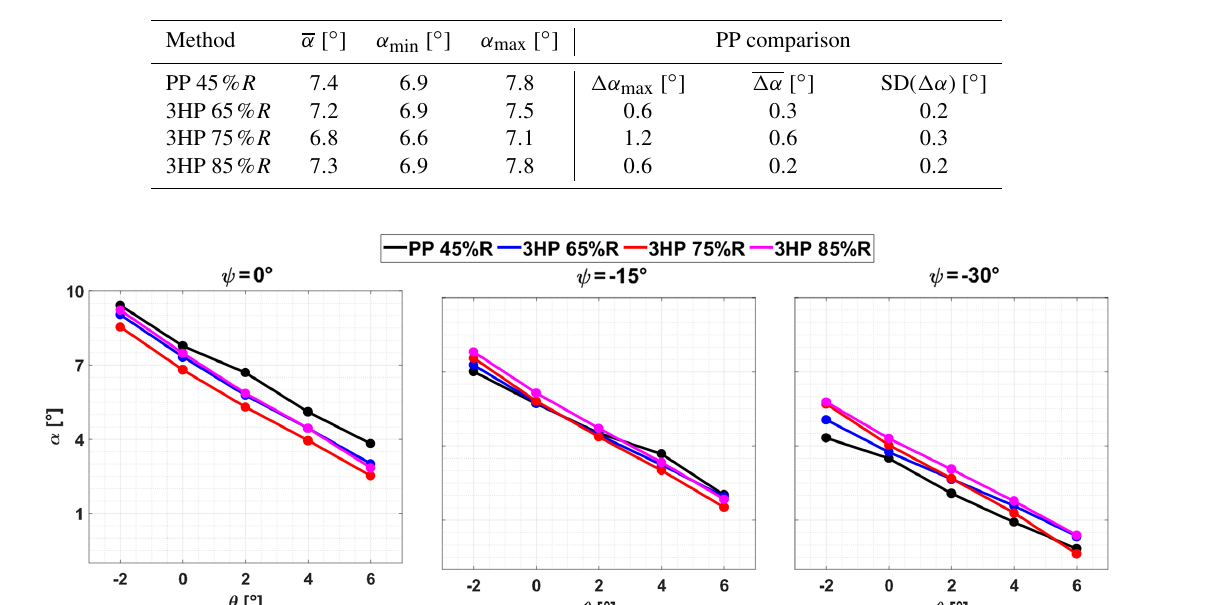
Table 3. AoA from the pressure taps and three-hole-probe methods at a yaw angle of ψ = 0 ◦ . Average, minimum and maximum for the pitch angle case θ = 0 ◦ .